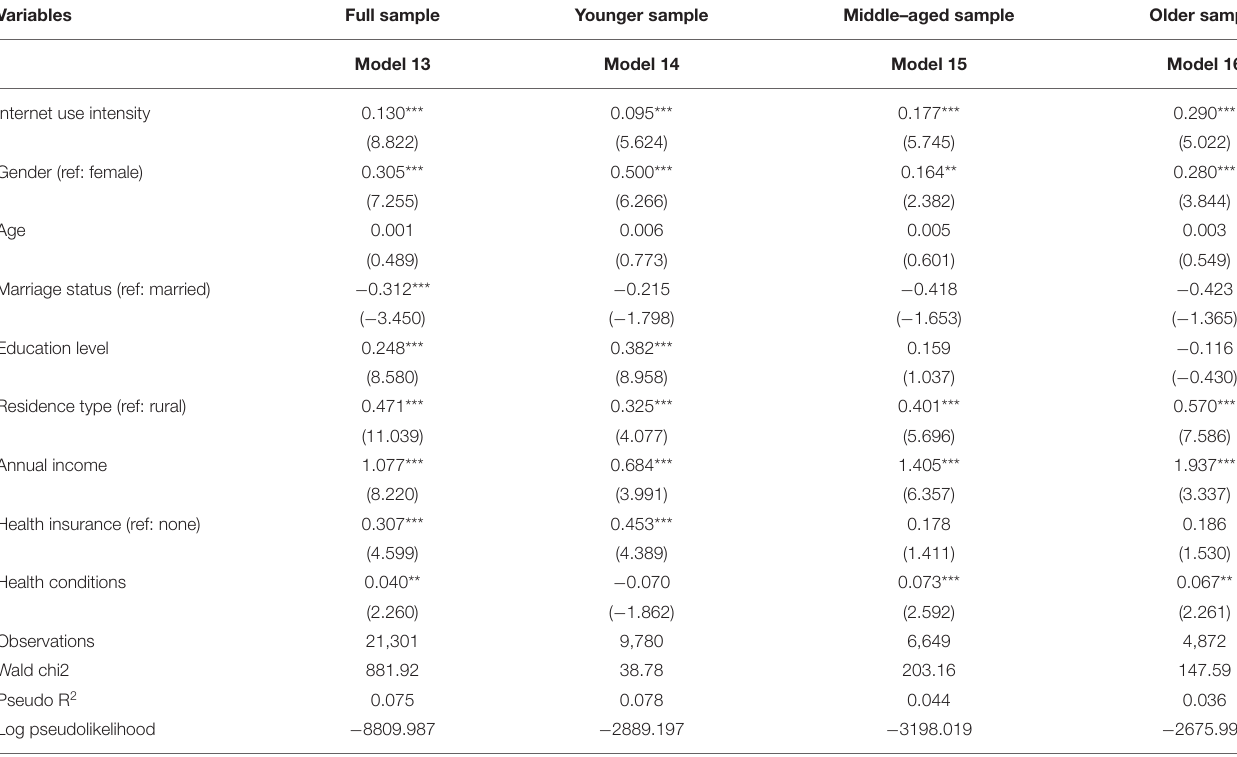
TABLE 6 | Results of the relationship between internet use intensity and dietary nutrition ( N =